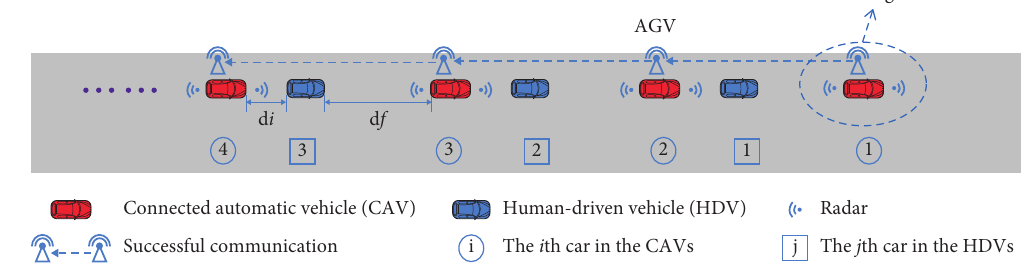
Figure 1: The layout of fleet in dense fog